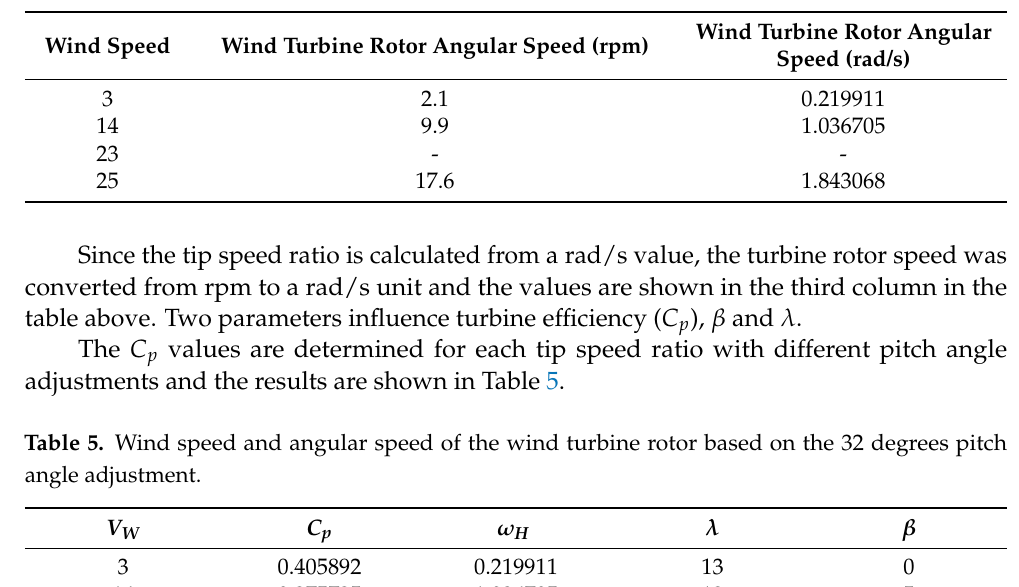
Table 4. Wind speed and angular speed of the wind turbine rotor.